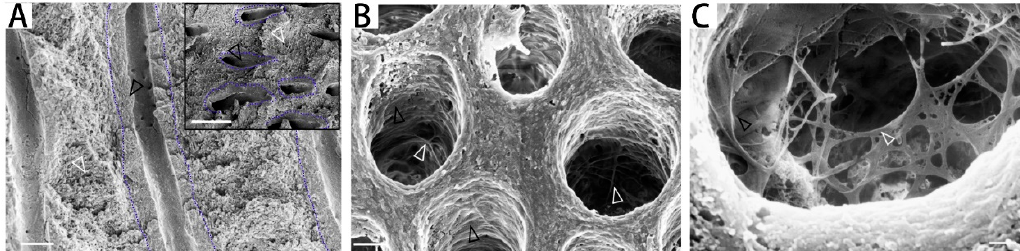
Figure 1. The nano-structure of dentin and DDM in scanning electron microscopy. ( A ) Dentin had micrometer-sized tubules. PTD was highly mineralized and collagen-free (black arrow). The mineral in ITD was embedded in collagen-rich matrix (white arrow). Scale bar = 1 µ m (larger figure). Scale bar = 2 µ m (inset). ( B ). Demineralization mainly dissolved the mineral in PTD, with opened and wider tubules, and a meshwork protruding towards the tubule lumen. Scale bar = 2 µ m. ( C ) Higher magnification of demineralized dentin showing a complex network of filaments protruding from tubule walls. Scale bar = 2 µ m. (From Berttasoni [37] in Micron , with permission.)